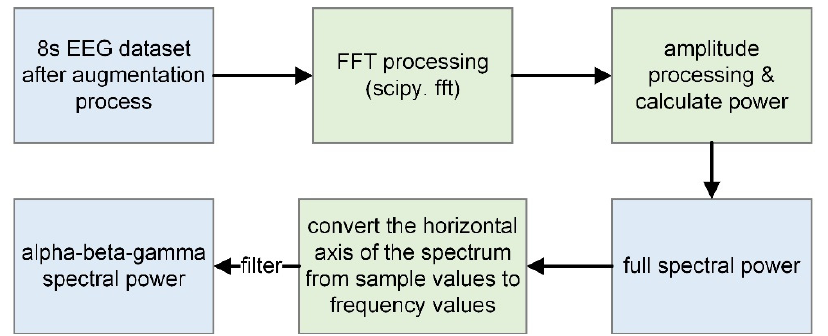
Figure 6. The process of obtaining the frequency domain signal.